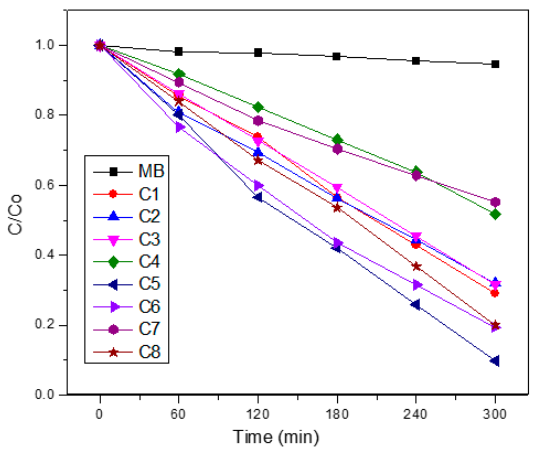
Figure 7. Photocatalytic behavior of NiO embedded in several matrices. Table 3. Kinetic data for the photodegradation process of MB with NiO and NiO / SiO 2, NiO / TiO 2